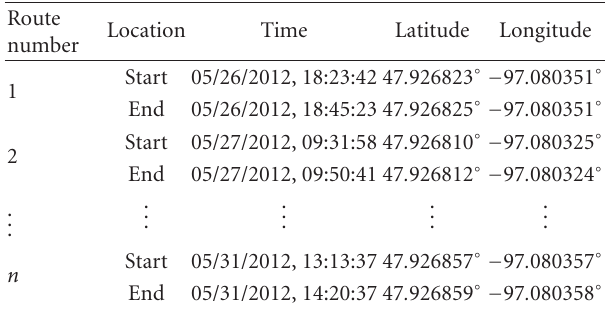
Table 2: Basic route information including route numbers, and start and end times and